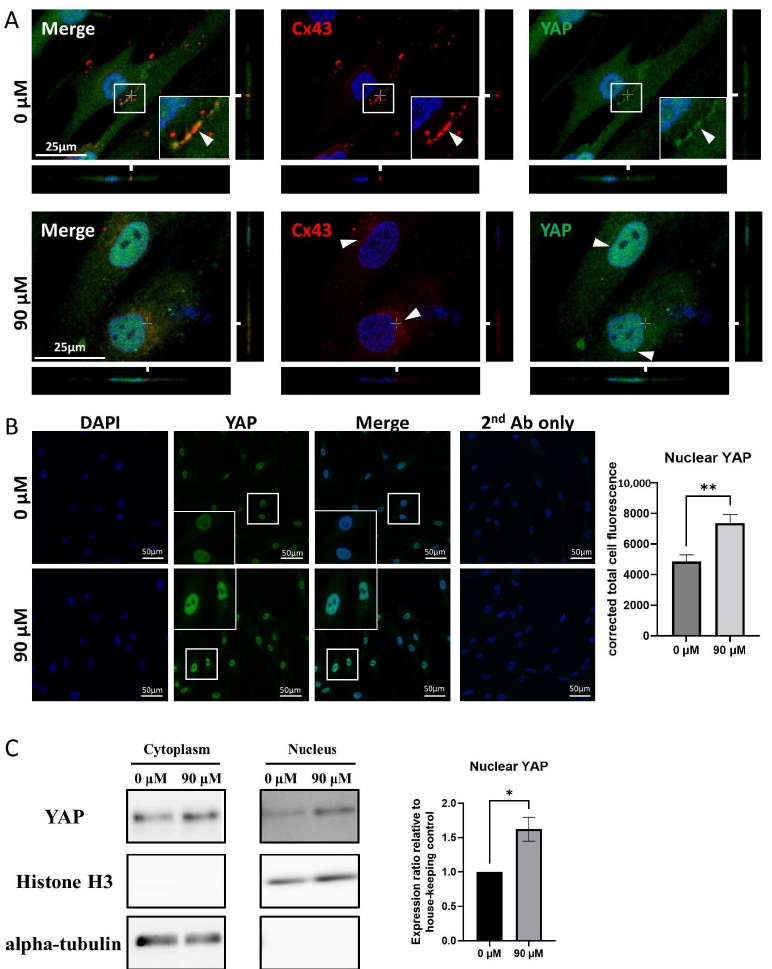
Figure 7. YAP and Cx43 dynamics in Muse cells before and after DDT treatment. ( A ) Immunocyto- chemistry imaging of Cx43 (red color-coded) and of YAP (green color-coded) in untreated- and DDT-Muse cells. DAPI (blue color-coded) was used for counter-staining. Co-localization of Cx43